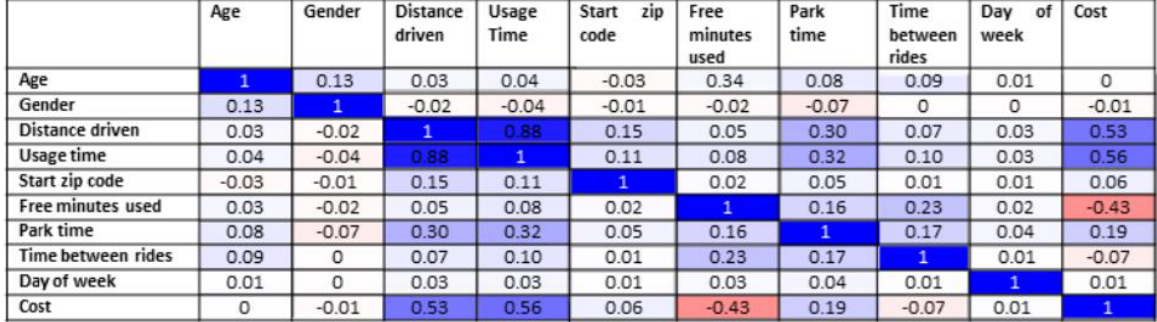
Table3. Spearman’s rho correlation